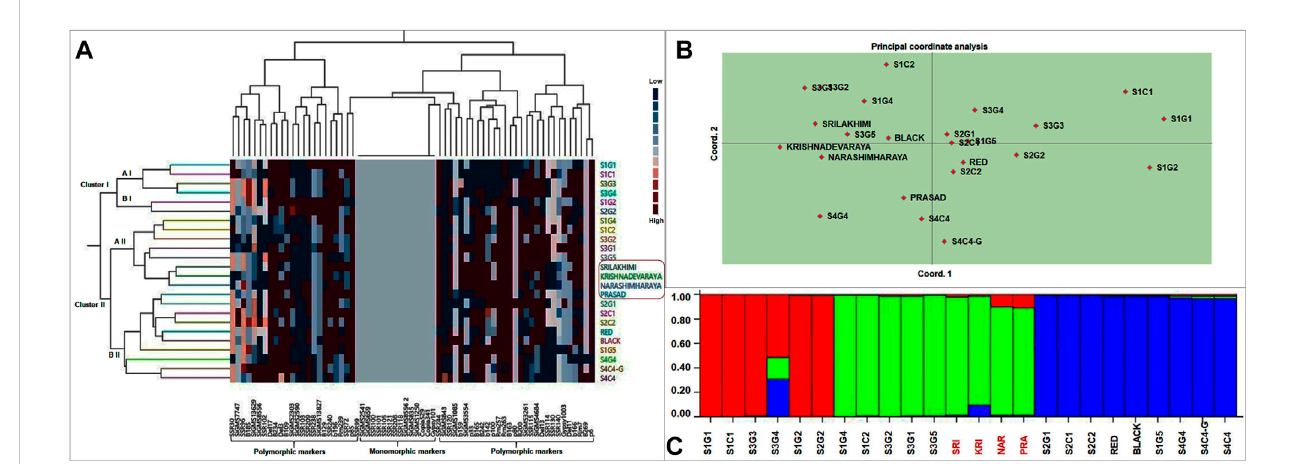
FIGURE 7 (A) Phylogenetic relationships between landraces and released cultivars of foxtail millet based on Euclidean Ward ’ s method of similarity coef fi cients computed from data matrix with polymorphic DNA bands generated from 67 molecular markers. In two way cluster analysis, fi rst dendrogram represent 24 foxtail millet genotypes and second dendrogram representing molecular markers (34 SSR, 21 EST SSR, 9 TE based and 3 rice SSR markers). Colored bars indicatedinthetwo-wayclustercorrespondingtothemarkerampli fi cationdata. (B) PrincipalCoordinateanalysisand (C) populationstructureanalysisof the twenty foxtail millet landraces along with four released cultivars based on 127 alleles generated from molecular